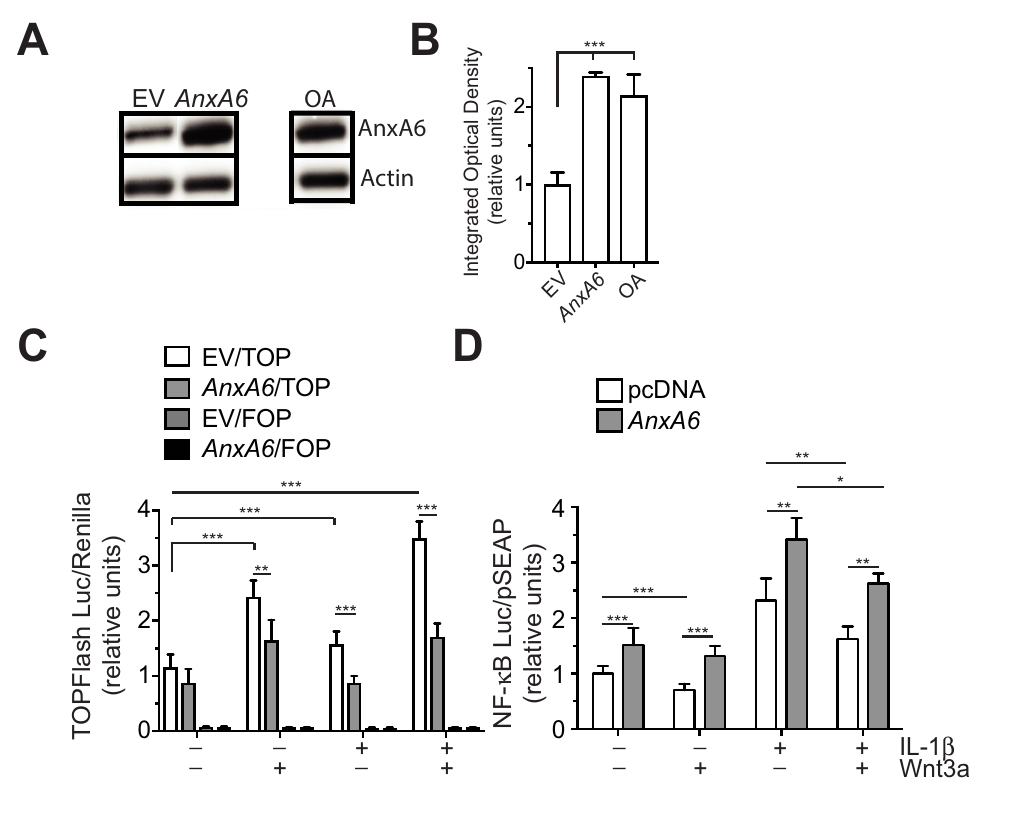
Fig 3. AnxA6 modulates the crosstalk between NF- κ B and ß-catenin signaling activities. A: Immunoblot analysis with antibodies specific for AnxA6 of a lysate from human articular chondrocytes transfected with empty pcDNA expression vector (EV) or pcDNA expression vector containing full-length AnxA6 cDNA ( AnxA6 ), or a lysate from late stage OA human articular cartilage tissue. Late stage OA cartilage was defined as deep fibrillated cartilage with loss of cartilage of the superficial and middle zones. Blots were also analyzed with antibodies specific for beta-actin to control for equal loading. B: The optical densities of the AnxA6 bands were quantitated by densitometry and normalized to the optical densities of the actin bands. Results are expressed relative to the normalized optical densities of the AnxA6 bands of human articular chondrocytes transfected with empty expression vector (EV), which were set as 1. The blot in A is representative of 3 separate experiments with similar results. The optical densities were analyzed on three different immunoblots, and values are mean ± SD. C: ß-catenin activity as determined by luciferase activity from the TOPFlash (TOP) or FOPFlash (FOP) luciferase reporter in vehicle-treated, Wnt3a-treated, IL-1ß-treated, Wnt3a/IL-1ß-treated human articular chondrocytes overexpressing AnxA6. After serum starvation, TOPFlash or FOPFlash reporter- and empty pcDNA (pcDNA)-transfected, or TOPFlash or FOPFlash reporter- and pcDNA containing full-length AnxA6 ( AnxA6 )-transfected human articular chondrocytes were vehicle-treated, or treated with Wnt3a, IL-1ß, or Wnt3a and IL-1ß for 24h. Cell extracts were then analyzed for luciferase activity. Transfection efficiency was monitored by co-transfection with Renilla luciferase vector, which provides constitutive expression of the Renilla luciferase reporter. D: NF- κ B activity as determined by luciferase activity from the pNF κ B-Met-Luc2 reporter in vehicle-treated, Wnt3a-treated, IL-1ß-treated, Wnt3a/IL-1ß-treated human articular chondrocytes overexpressing AnxA6. After serum starvation, pNF κ B-Met-Luc2 reporter- and empty pcDNA (pcDNA)-transfected, or pNF κ B-Met-Luc2 reporter- and pcDNA containing full-length AnxA6 ( AnxA6) -transfected human articular chondrocytes were vehicle-treated, or treated with Wnt3a, IL-1ß, or Wnt3a and IL-1ß for 24h. Samples were then analyzed for luciferase activity. Transfection efficiency was monitored by co-transfection with pSEAP vector, which provides constitutive expression of human placental alkaline phosphatase (SEAP). Secreted SEAP activity was monitored with the chemiluminescence substrate CSPD. Values in C and D were normalized to Renilla or pSEAP luciferase activity. Data are expressed relative to the normalized luciferase activity levels of vehicle-treated WT cells transfected with empty expression vector, which was set as 1. Data in C and D ( n = 4) are expressed as mean ± SD. ( (cid:3) p < 0.05; (cid:3)(cid:3) p < 0.01; (cid:3)(cid:3)(cid:3) p <